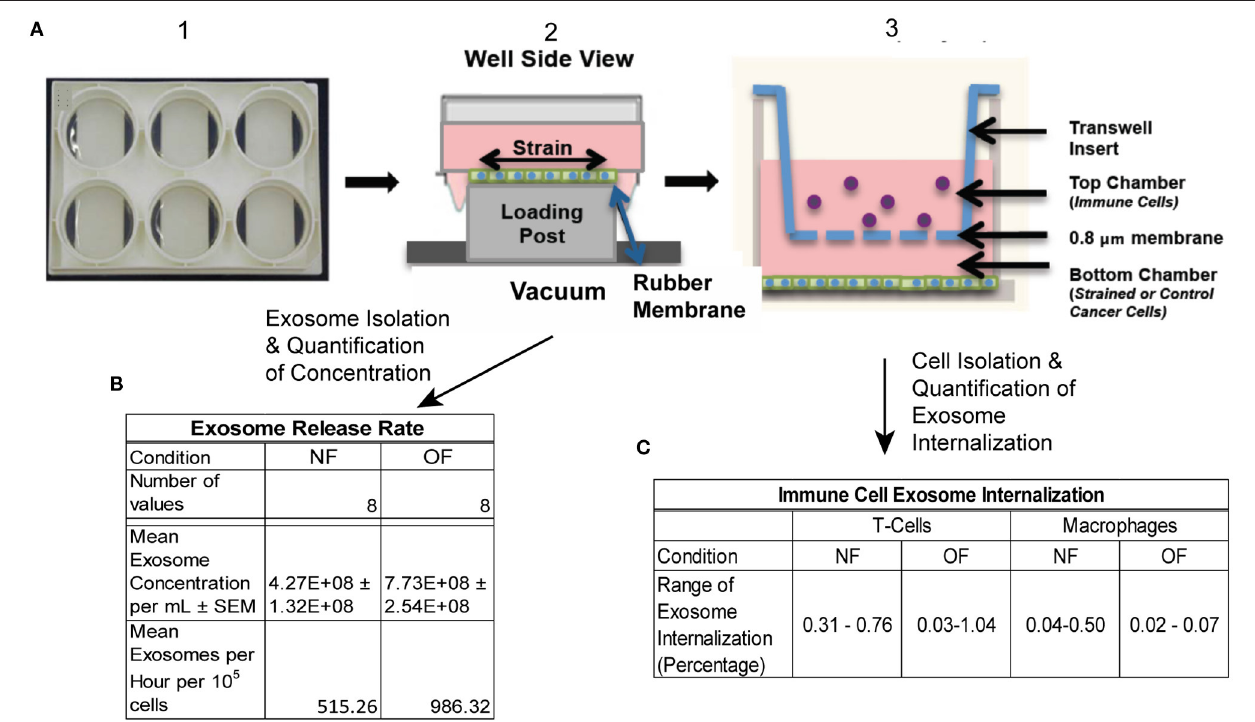
FIGURE 1 | Schematic of experimental protocol. (A) 4T1.2 cells were seeded in BioFlex plates (1), once cells reached confluence they were exposed to OF strain (or NF) (2). Strain exposed (or NF) cells were either put into co-cultured with immune cells (T cells and macrophages) using transwell (3) or conditioned media was collected for exosome isolation. (B) Exosome release rate quantified following OF or NF. n = 8 per condition from 3 experiments, 2–3 replicates per experiment. (C) Exosome internalization by T cells and macrophages was quantified using Imagestream flow cytometry, n = 2–3 per condition.